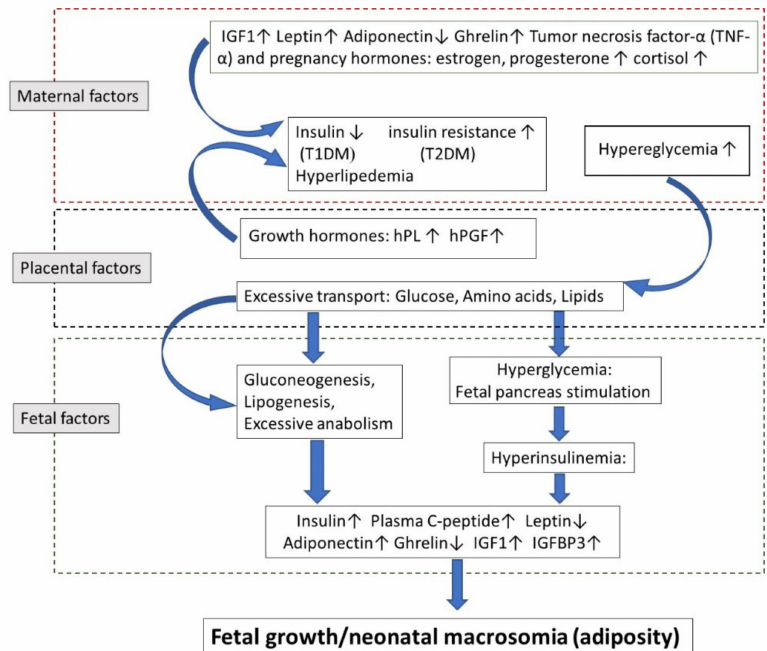
Figure 1. Factors affecting fetal growth in diabetic pregnancies. Insulin resistance is mediated by the secretion of pregnancy-associated hormones like estrogen, progesterone, cortisol, cytokines, and by other growth hormones secreted by the placenta entering the maternal circulation, like hPGH and placental lactogen. In addition, adipose tissue produces adipocytokines, including leptin, adiponectin, tumor necrosis factor- α (TNF- α ), that are possibly contributing to insulin resistance. Generally, insulin resistance induces glucose intolerance, resulting in hyperglycemia. This, in turn, causes placental changes and excessive glucose, amino acid, and lipids in the fetus. The fetus responds to maternal hyperglycemia by hyperinsulinemia, which in turn reduces fetal blood glucose levels but also increases fetal adipose tissue and enhances growth. In addition, PGH facilitates fetal gluconeogenesis and lipogenesis, further contributing to enhanced fetal